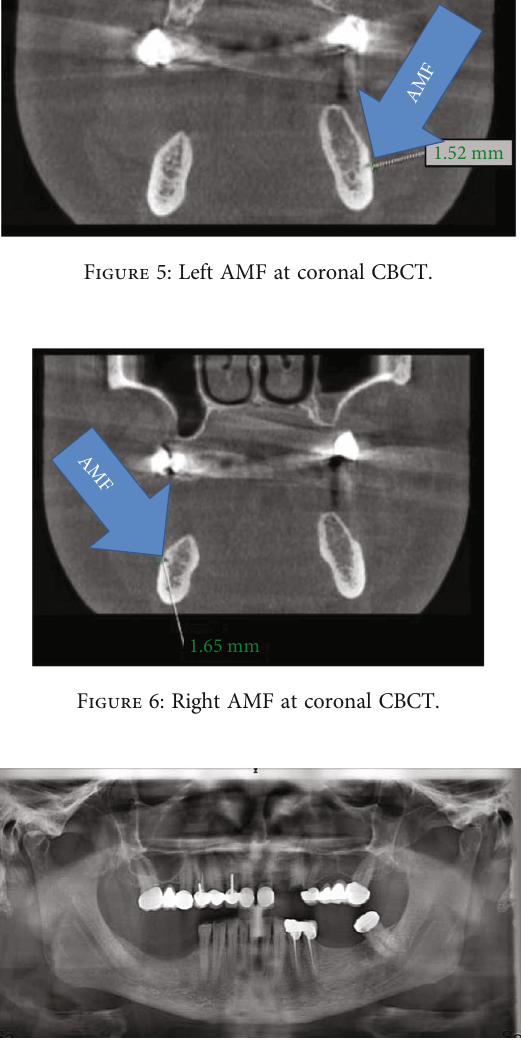
Figure 7: Patient ’ s